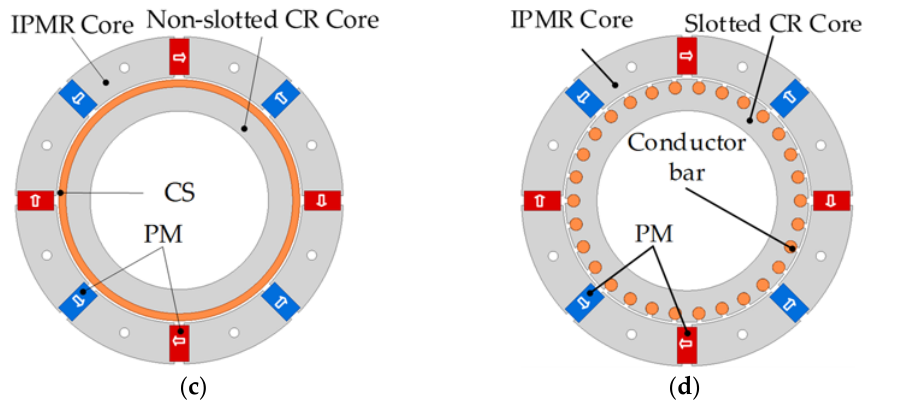
Figure 1. The cross section of four typical permanent magnet eddy current couplers (PMECCs): ( a ) Model − A (surface-mounted permanent magnet rotor (SPMR) and non-slotted conductor rotor (CR)); ( b ) Model − B (SPMR and slotted CR); ( c ) Model − C (interior permanent magnet rotor (IPMR) and non-slotted CR); ( d ) Model − D (IPMR and slotted CR).